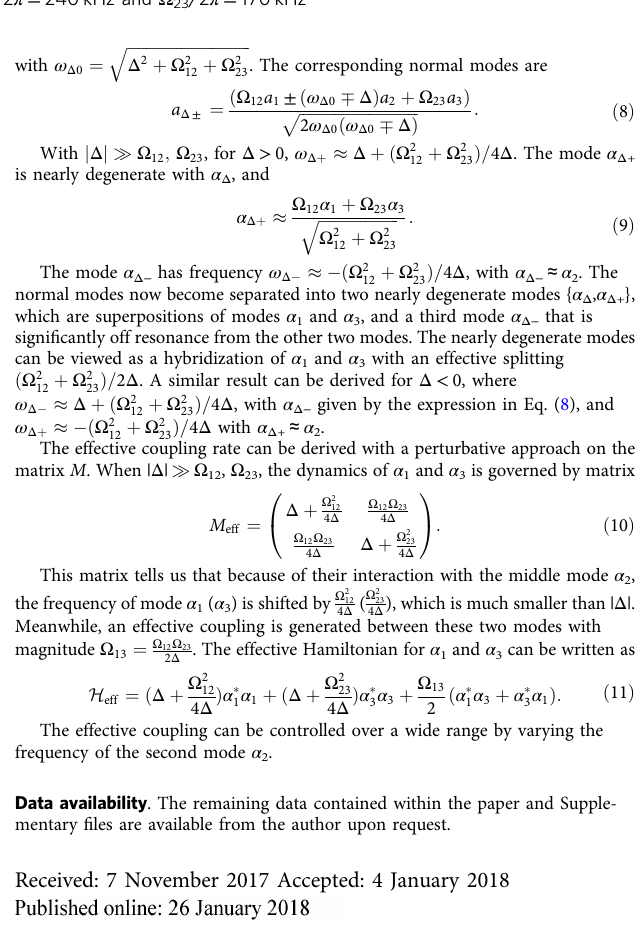
Fig. 3 Indirect coupling between separated resonators via a phonon cavity. a Raman-like coupling between modes R 1 and R 3 via virtual excitation of the phonon cavity R 2 . The coupling strength can be controlled by changing the detuning Δ 12 . b Effective coupling as a function of Δ 12 . The error bars are obtained from the s. e. m. of the measured data and are extracted from the statistical deviation of the estimated values at different detunings from Supplementary Fig. 7. The red line is given by Ω 13 = Ω 12 Ω 23 /2 Δ 12 , with Ω 12 /2 π = 240 kHz and Ω 23 /2 π =